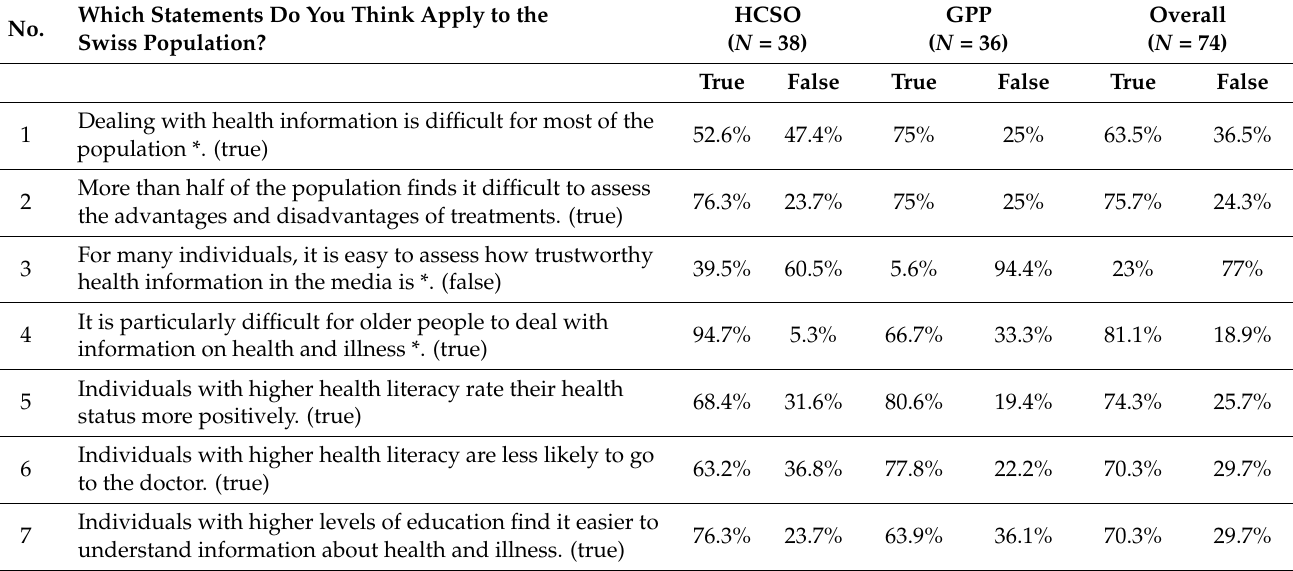
Table 3. Health professionals’ assessment of statements regarding health literacy of the Swiss